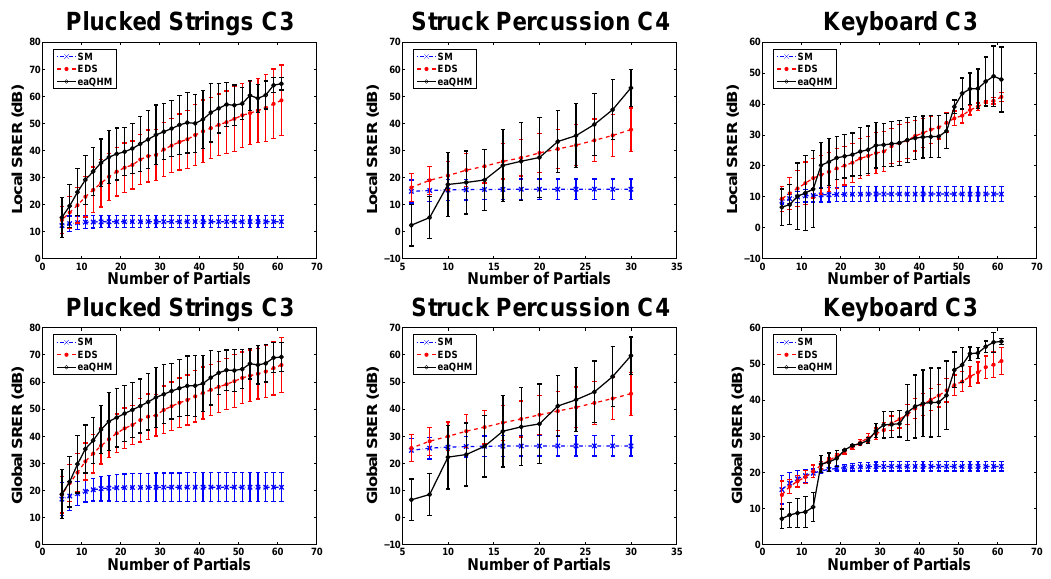
Figure 5. Comparison between local and global SRER as a function of the number of partials for the three models (the standard sinusoidal model (SM), exponentially damped sinusoids (EDS), and eaQHM). The bars around the mean are the standard deviation across different sounds from the family indicated. The distributions are not symmetrical as suggested by the